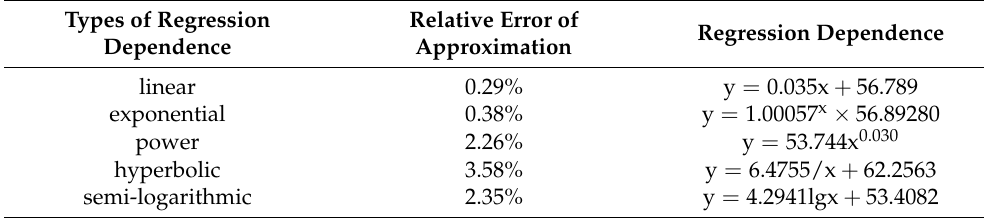
Table 4. Types of the regression dependence and their relative errors of approximation in the AMD heating process.